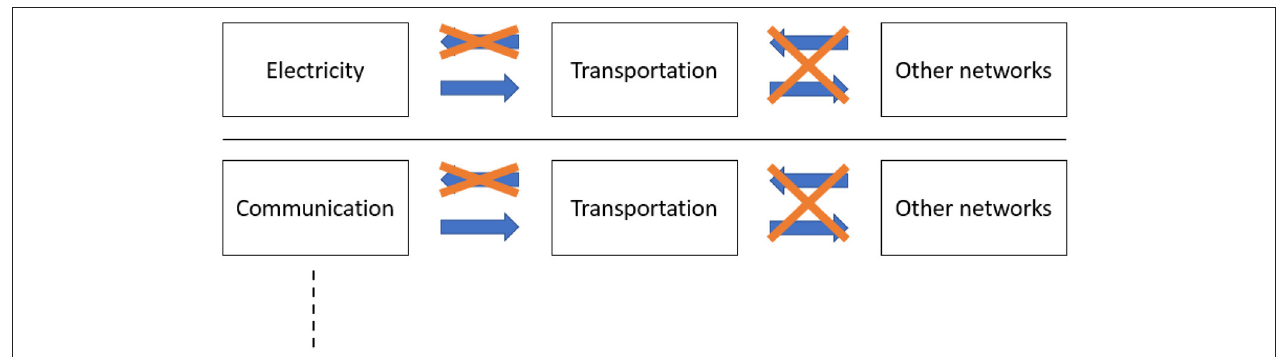
Frontiers in Sustainability |